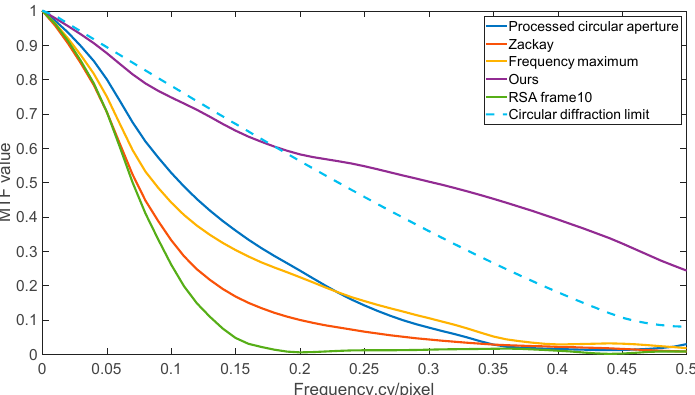
Figure 15. MTF comparison of synthetic results. MTF was calculated by utilizing the edge areas shown in Figure 14, and we used the proposed simulation model to acquire a 0.1m circular aperture’s diffraction limit, as shown by the dotted line.